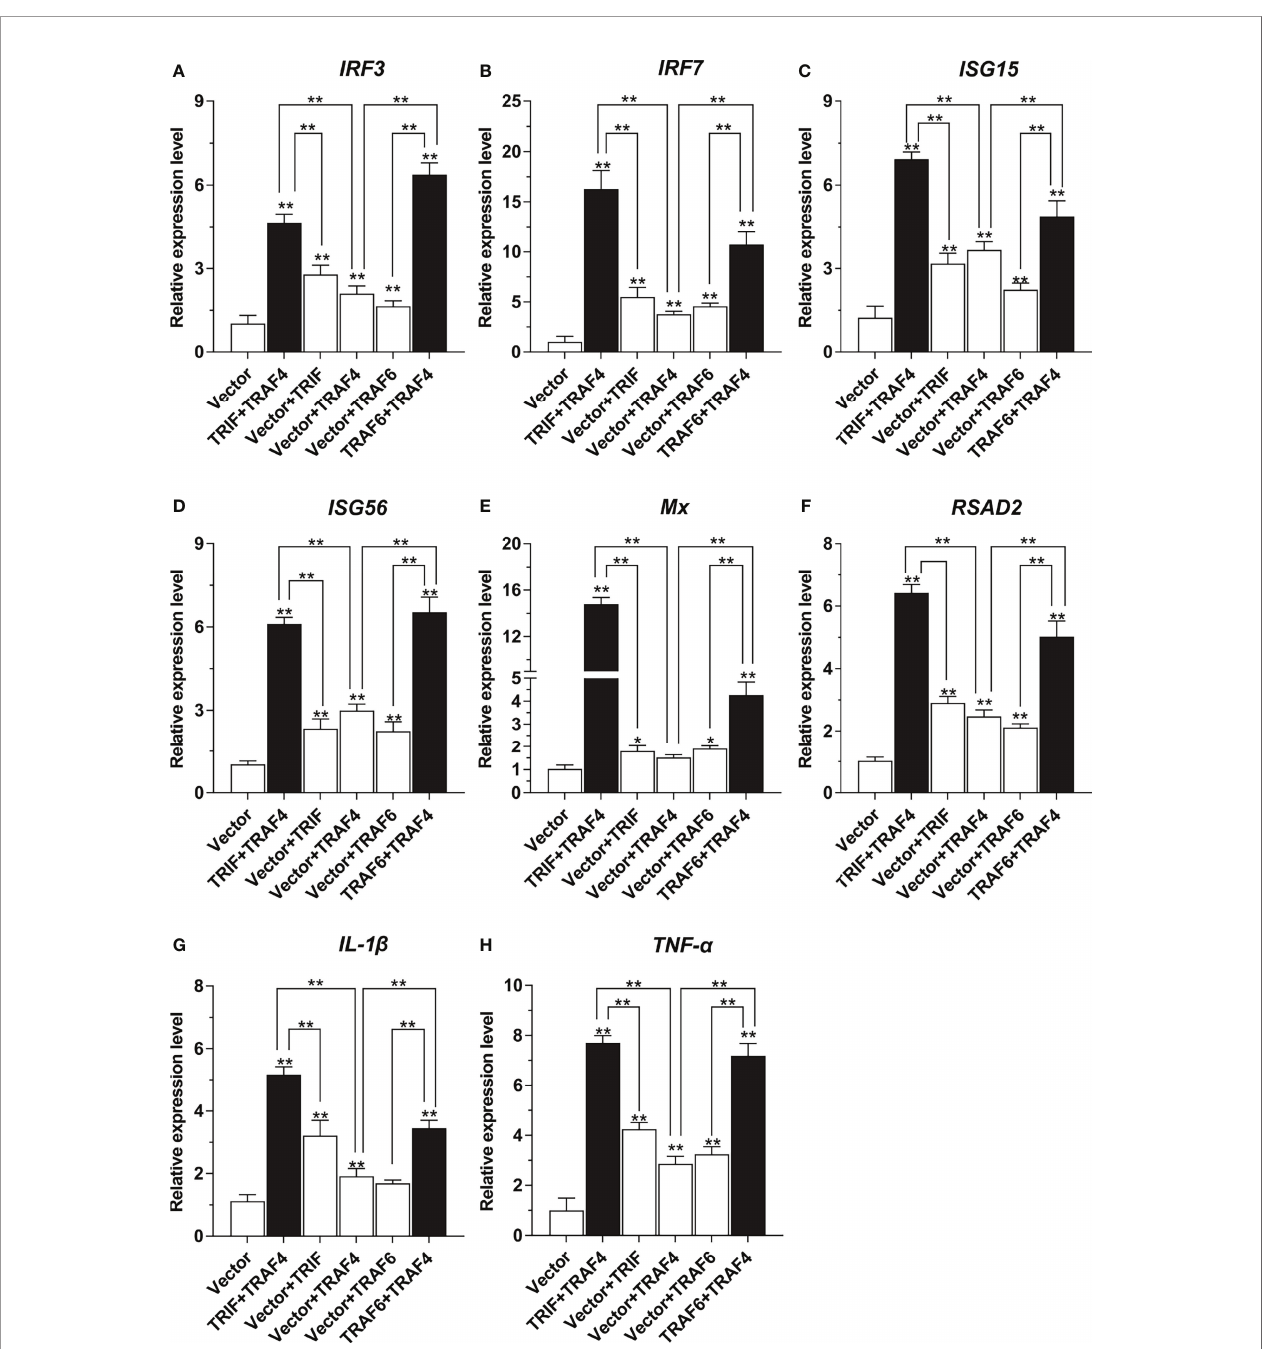
FIGURE 8 | Association of Lc -TRAF4 with Lc -TRIF and Lc -TRAF6 in the induction of antiviral and in fl ammation-related genes expression. LYCMS cells were co- transfected with pcDNA3.1-TRAF4, pcDNA3.1-TRIF, and pcDNA3.1-TRAF6 alone or in a combination of two, with the total amounts of the transfected plasmids balanced by the pcDNA3.1 empty vector for each transfection. The cells were then collected for total RNA extraction and cDNA synthesis at 48 hpt. The mRNA expression levels of antiviral and in fl ammation-related genes, including IRF3 (A) , IRF7 (B) , ISG15 (C) , ISG56 (D) , Mx (E) , RSAD2 (F), IL-1 b (G) , and TNF- a (H) were examined by qRT-PCR, with the results calculated by the normalization to the expression of b -actin and then recorded as a fold change compared to the control group. All of the data were shown as mean ± SE from three independent experiments, with bars representing SE. * P < 0.05, ** P <